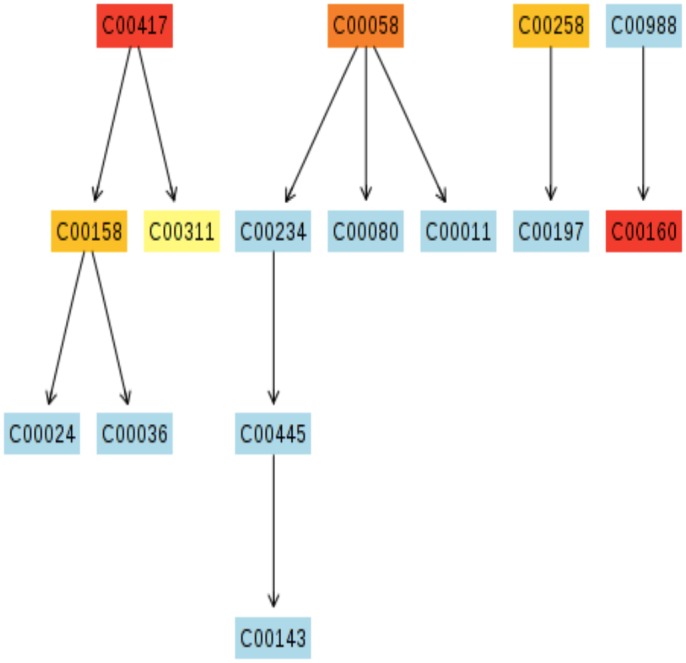
Putative metabolic pathways associated with the wound environment of chronic pressure ulcers.Significantly contributing pathway nodes include glyoxylate and dicarboxylate metabolism. Highlighted metabolites indicated hits from the metabolic profiling and are coded according to p-value. Pathway maps are generated using the KEGG reference map (http://www.kegg.jp/kegg/pathway.html).